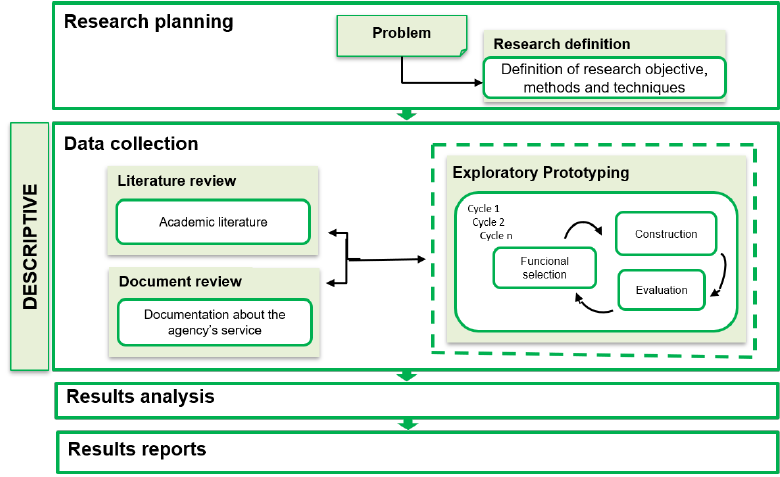
Figure 3. Methodological plan adopted in this